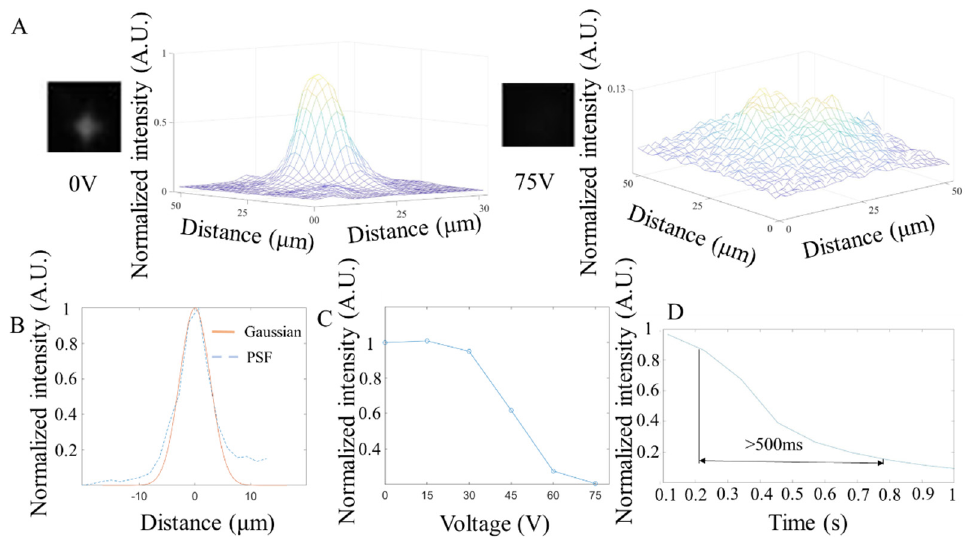
Figure 6. Characterization of the NLC at 515 nm wavelength. ( A ). The microscope image of the NLC and the light intensity distribution color map at 0 V ( left ) and 75 V ( right ). ( B ). The NLC’s point spread function and Gaussian fitting curve at 0 V. ( C ). Average measurement of light intensity changes under different voltages. ( D ). Average response time (change from 90% to 10% of the normalized light intensity step height) of the NLC under 75 V (N = 6).